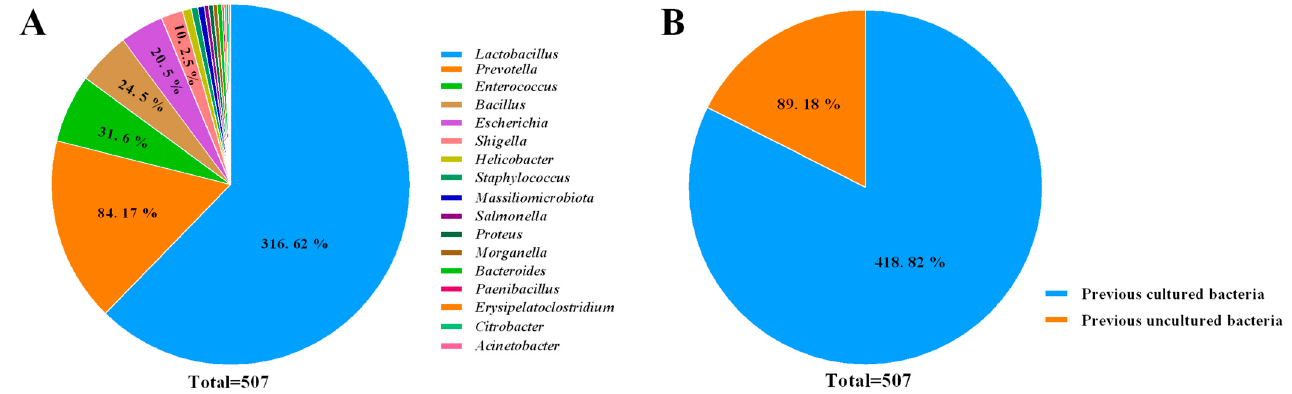
Figure 1. Diversity of the chicken intestinal microbiota strain collection. ( A ) Taxonomic distribution of genus level of total pure cultured bacteria isolated from chicken intestine; ( B ) The percentage of previously cultured and uncultured chicken intestinal bacteria. Table 1. The statistics of isolates from the chicken intestine.